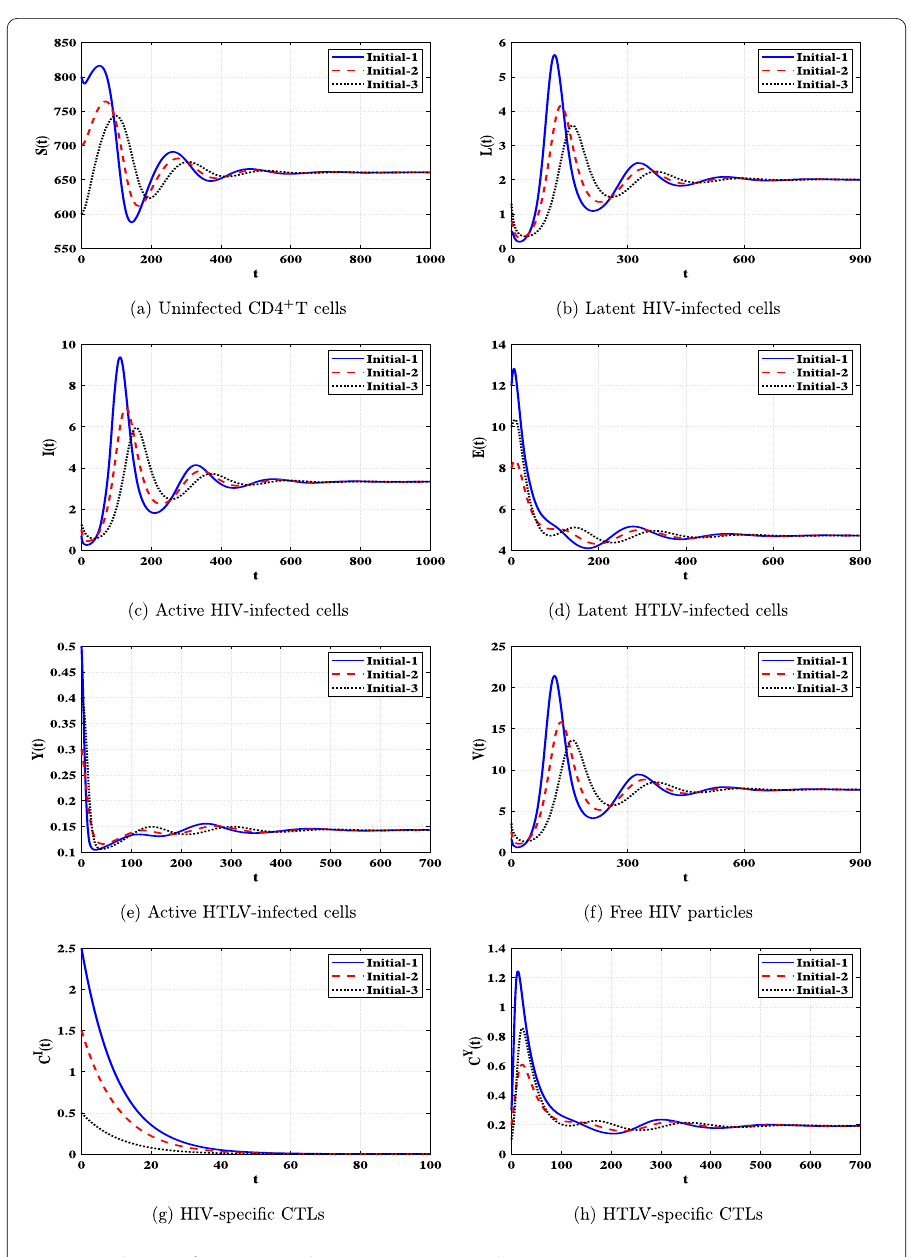
Figure 7 Solutions of system (29) when (cid:9) 6 > 1, (cid:9) 7 ≤ 1, and (cid:9) 2 / (cid:9) 1 > 1